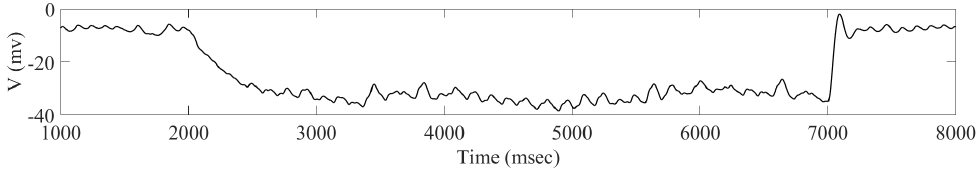
Figure 15. The total filtered local field potential of the 16 STN neurons from 1000 to 8000 ms with aLFPDBS parameters a 0 = 15 and intt =